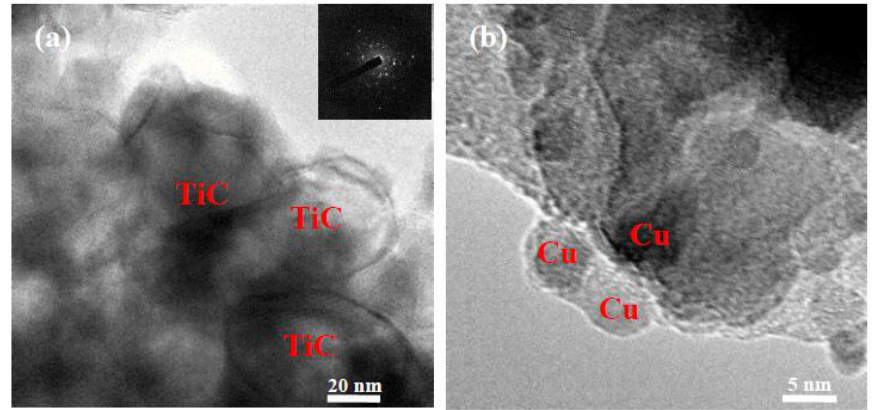
Figure 7. TEM images and SADP of nanocomposite A of 30 vol % TiC–Cu composition sintered at 900°C: ( a ) bright-field image (inset: SADP corresponding to a TiC crystallite); ( b ) HRTEM of the Cu matrix.